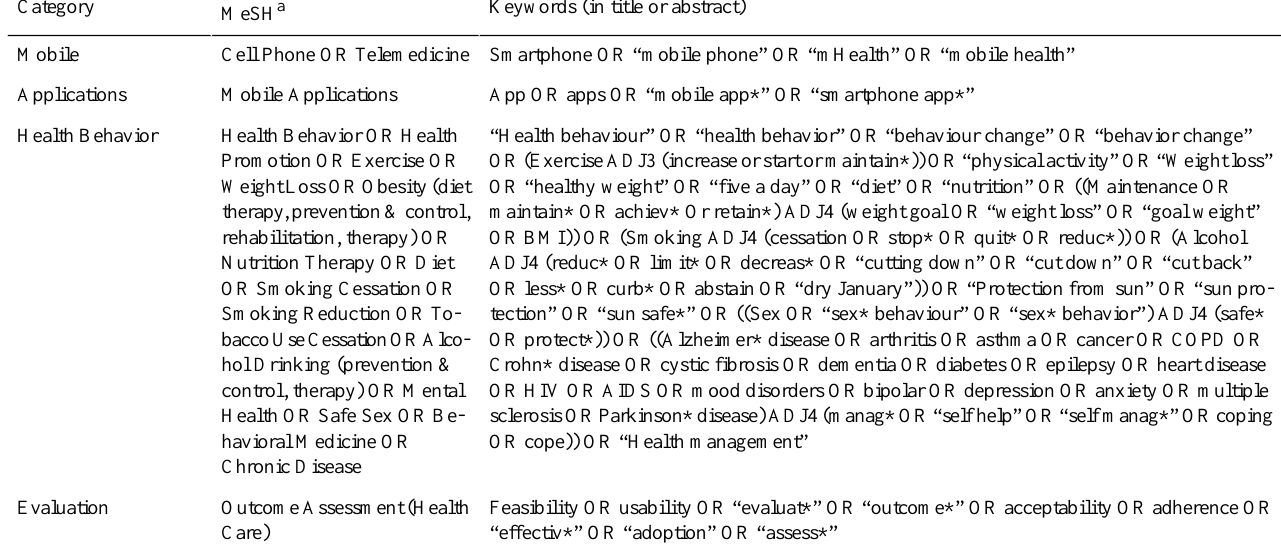
Smartphone OR “mobile phone” OR “mHealth” OR “mobile health”Cell Phone OR